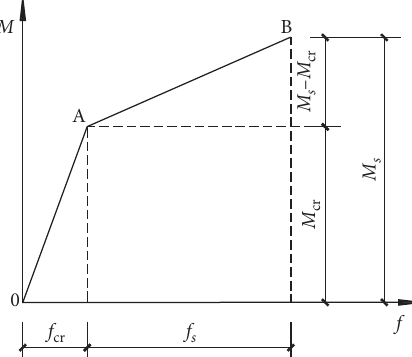
Figure 7: Bending moment-deflection curve of the prestressed